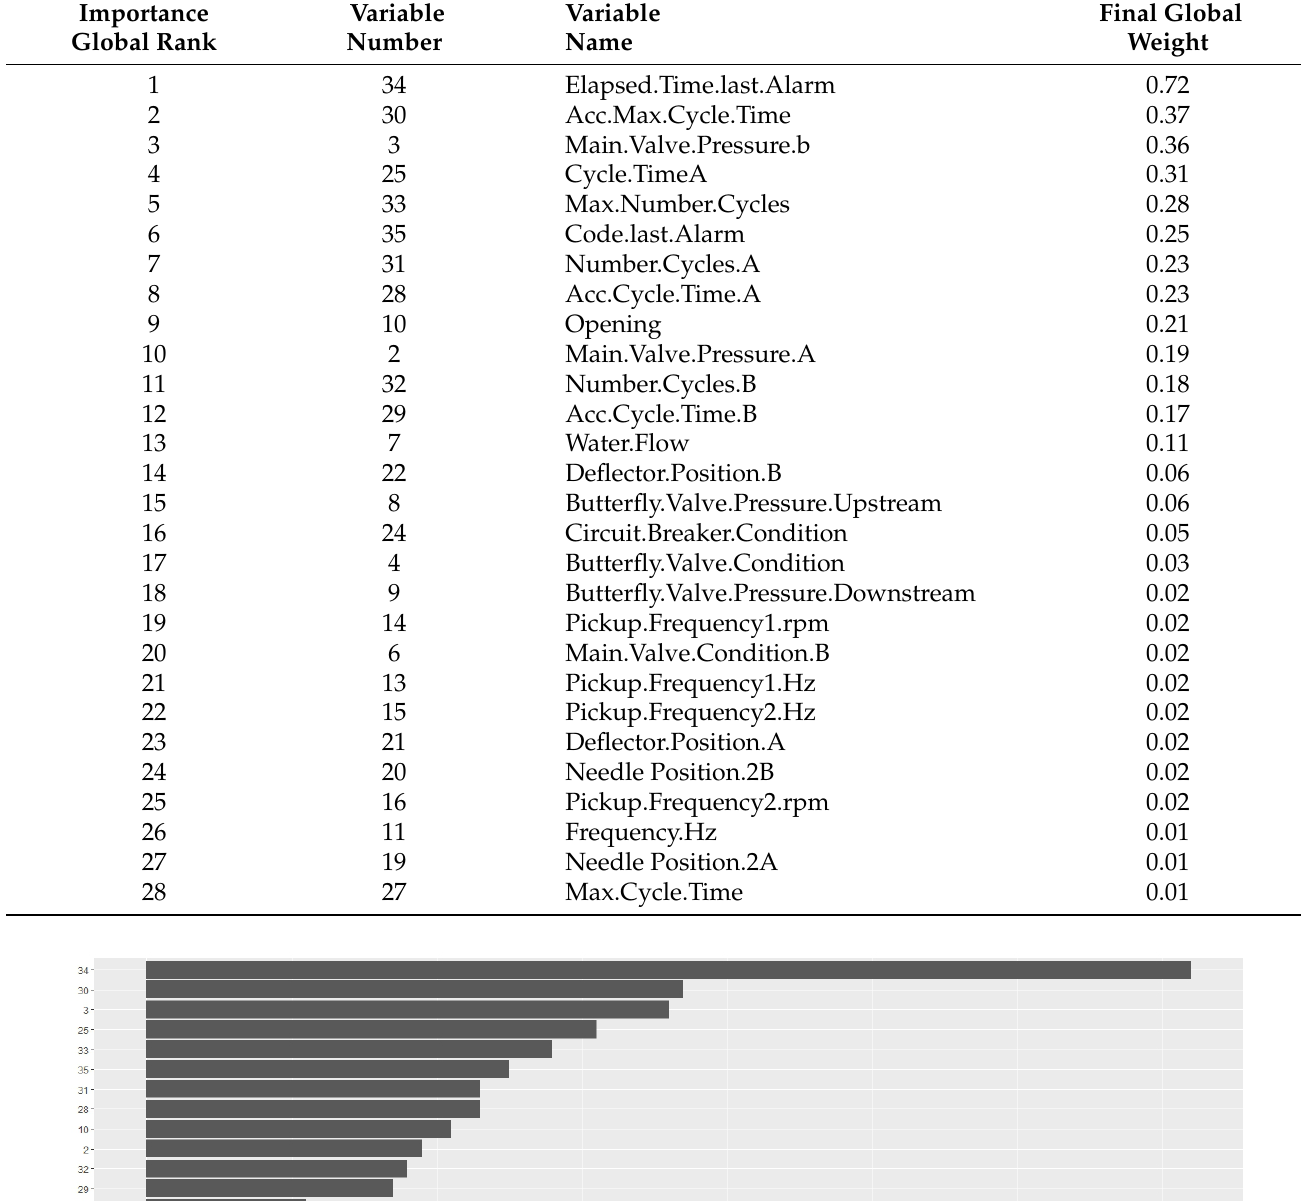
Table 6. Final Ranking of Global Most Important Variables.